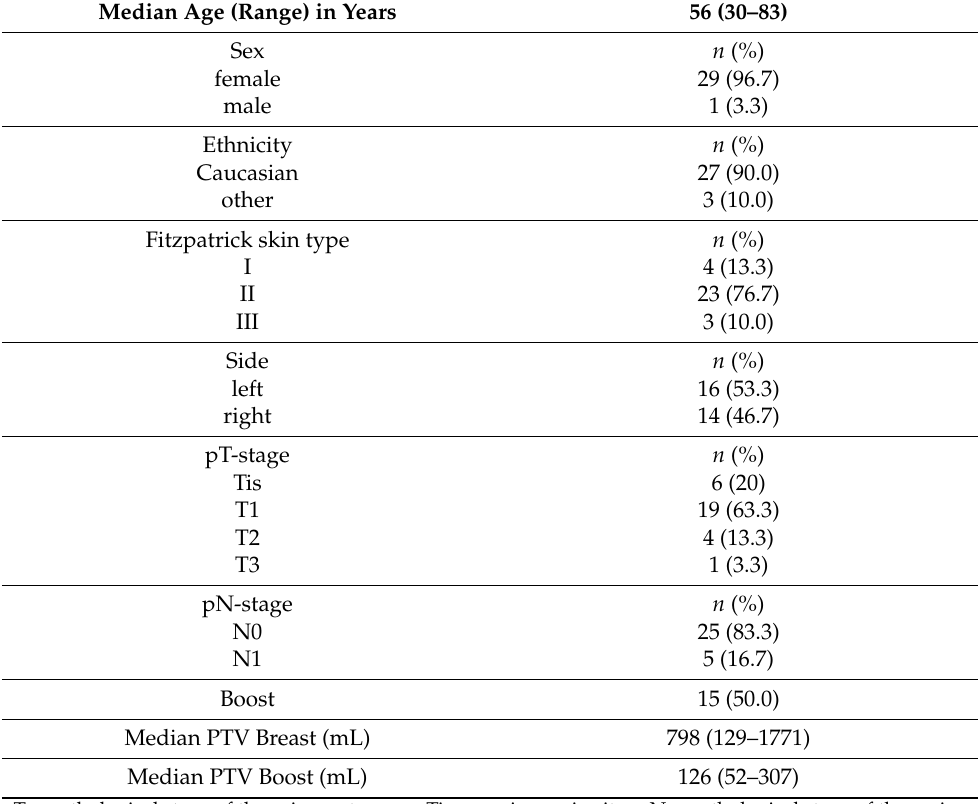
Table 2. Summary of patient and treatment characteristics ( n =